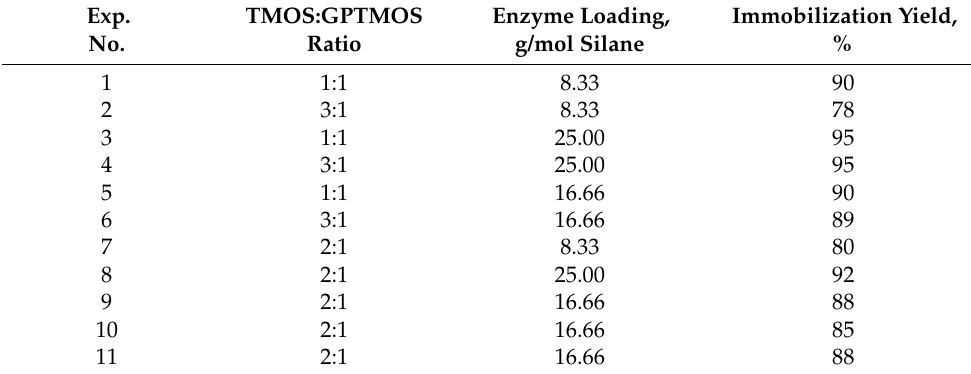
Table 3. Immobilization yields (%) for the sol-gel entrapment of Candida antarctica B lipase.